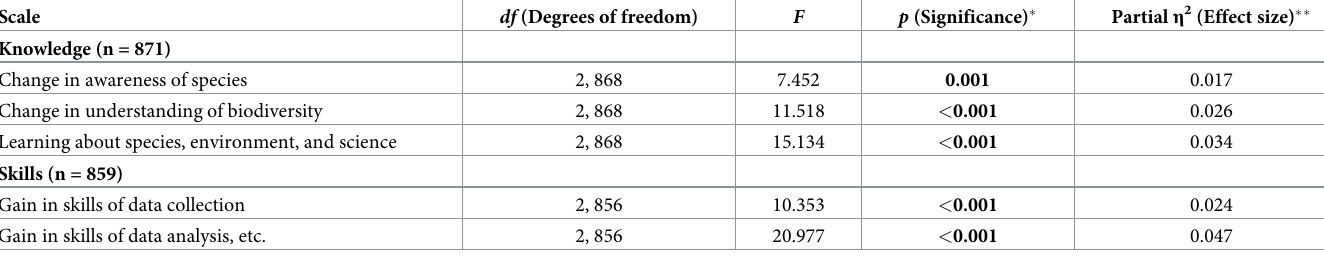
Table 6. Results of the one-way independent ANOVA test for the amount of in-person training received by the project participants. Scale df (Degrees of freedom) F p (Significance) � Partial η 2 (Effect size)